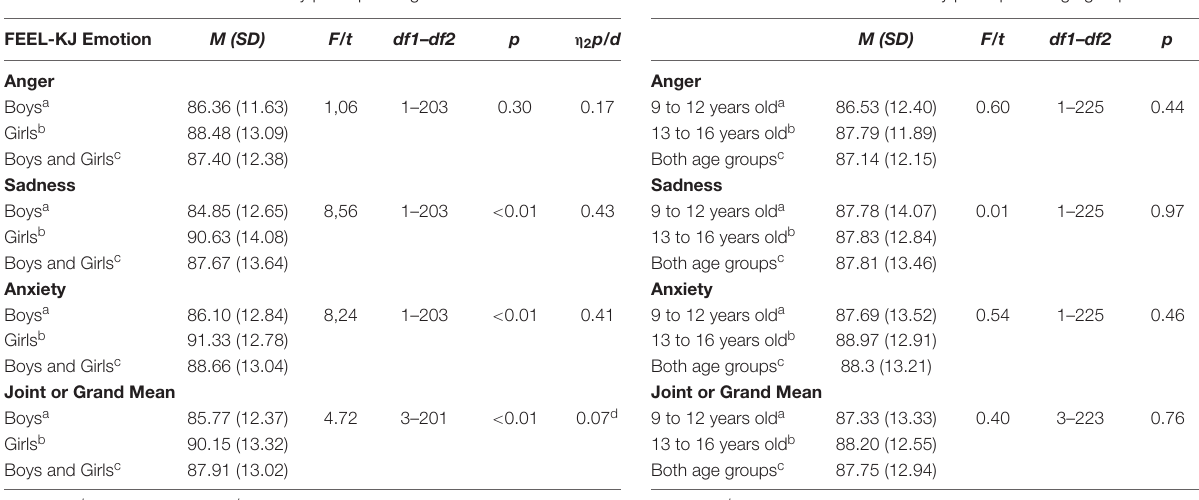
TABLE 5 | Descriptive statistics and hotelling T 2 test results for differences in the FEEL-KJ emotions Subscales Scores by participants’ gender.